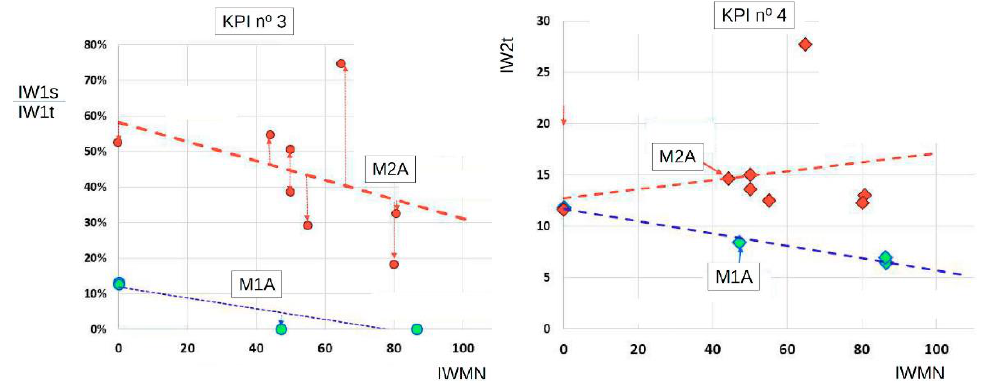
Figure 8. Graph of the values of KPI N° 3 ( left ) and N° 4 ( right ) corresponding to the machines whose data were